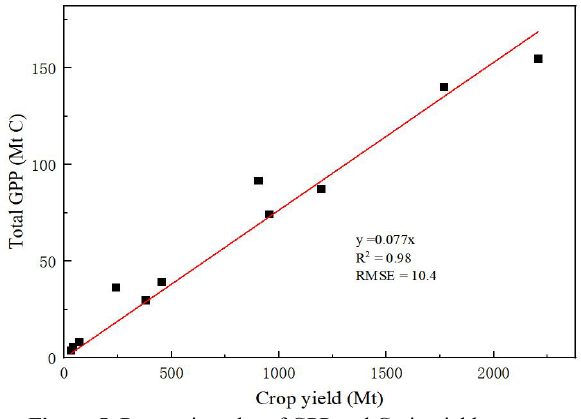
Figure 5 . Regression plot of GPP and Grain yield.